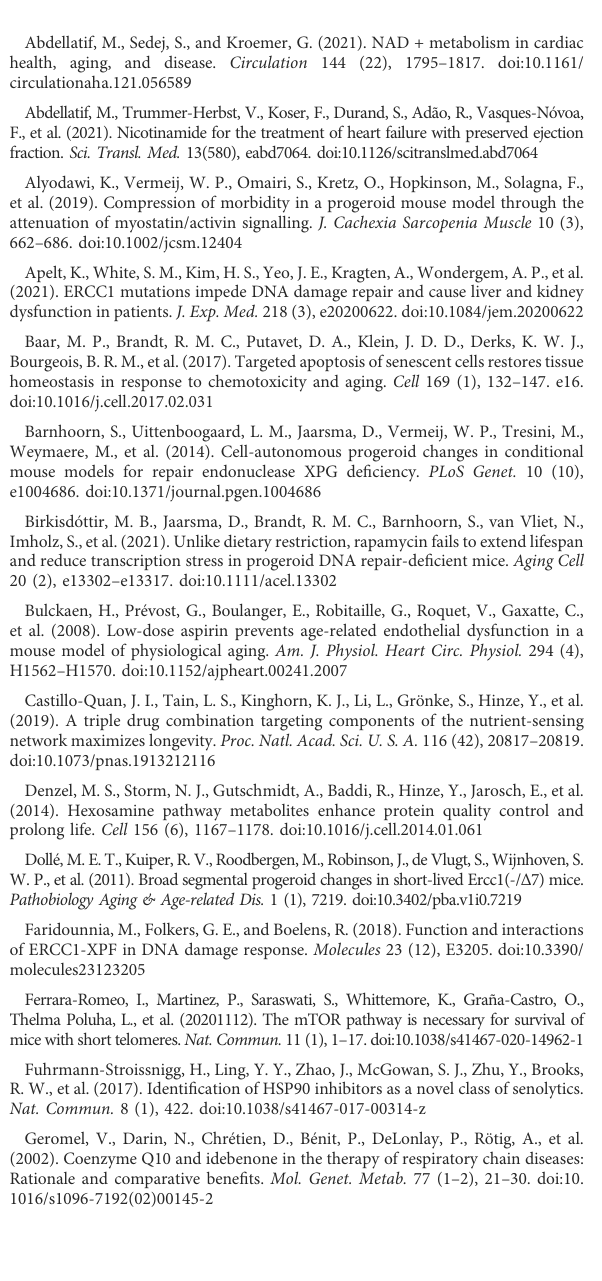
SUPPLEMENTARY FIGURE S5 Trehalose does not bene fi t neurological health in Xpg − / − mice. (A – D) ,